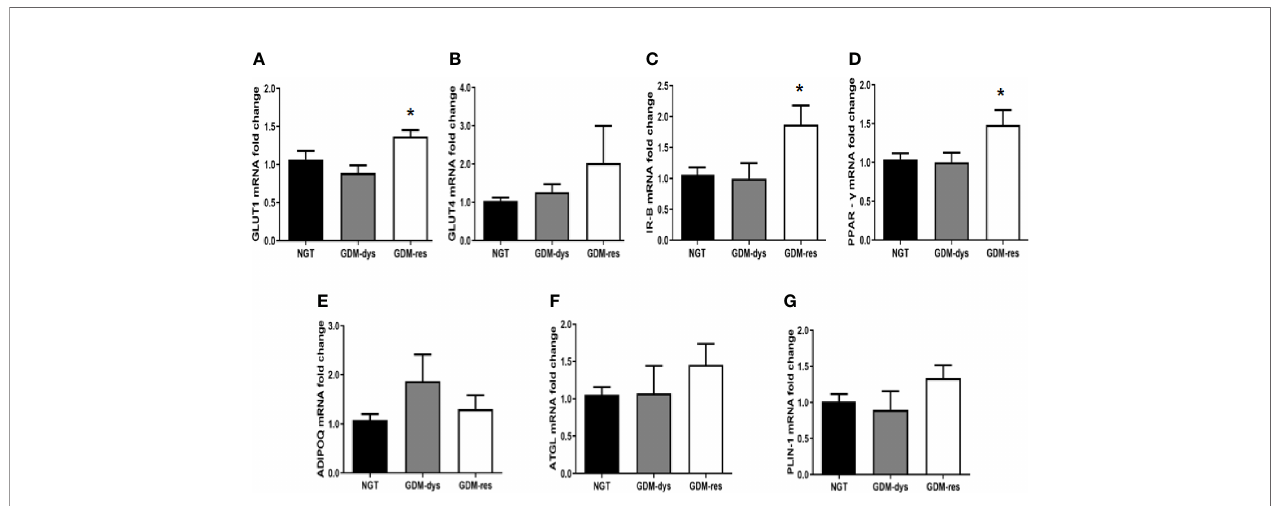
FIGURE 3 | | Relative expression of genes involved in glucose uptake, insulin sensitivity and lipolysis in vWAT. (A ‒ G) Gene expression of GLUT1, GLUT4, IR-B, PPAR- g , ADIPOQ, ATGL, PLIN-1. * P < 0.05 vs. NGT group. Data were analyzed by a one-way ANOVA with Tukey post hoc test. NGT, n = 13; GDM-res, n = 17; GDM-dys, n = 9.